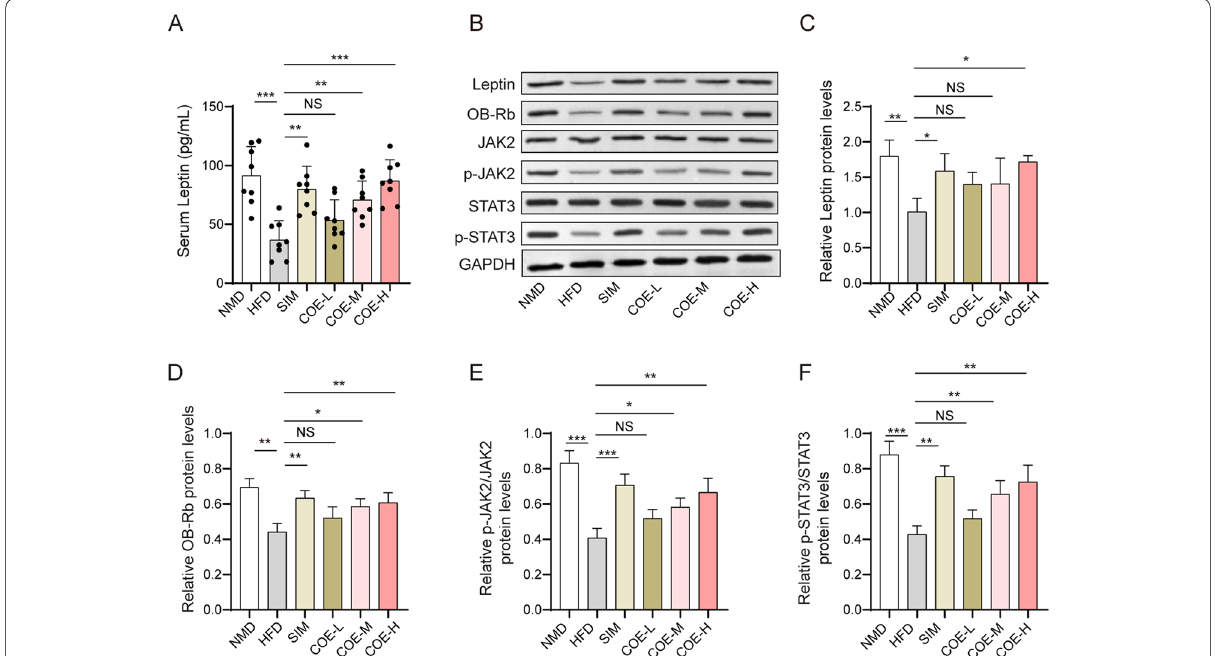
Fig. 7 The role of COE in leptin/JAK2/STAT3 pathway activation. A Serum leptin levels were measured via ELISA. B – F Leptin and OB-Rb levels and JAK2 and STAT3 phosphorylation in hepatic tissues were examined via western blotting. n